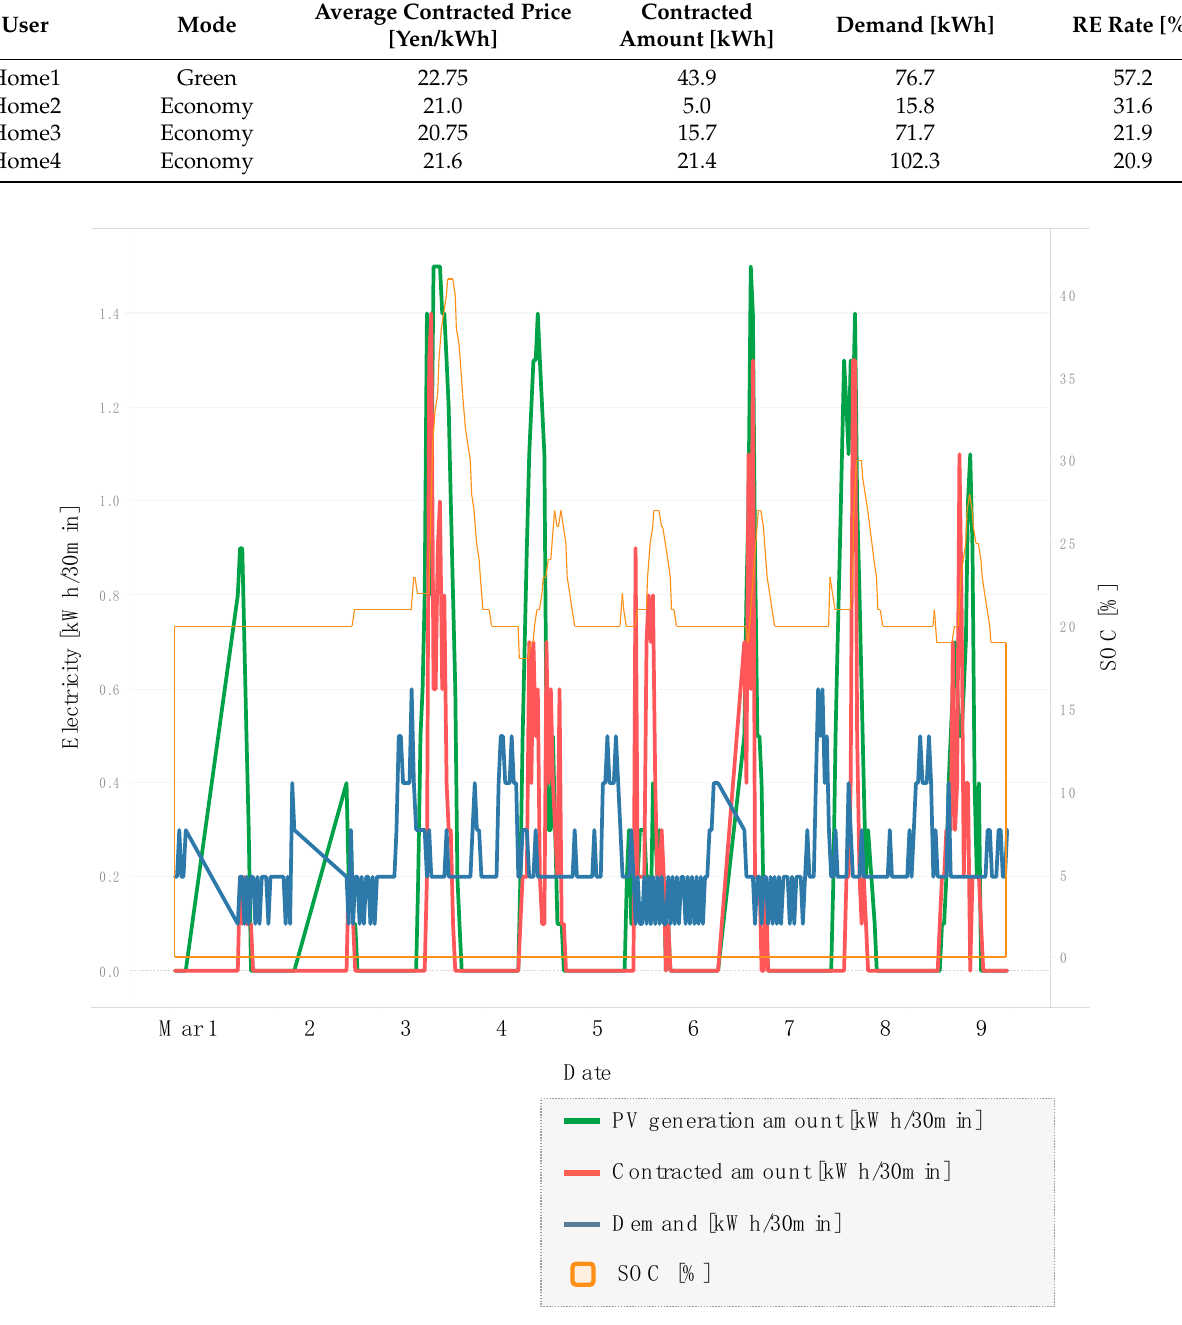
Table 4. Summary of trading results for the second week.